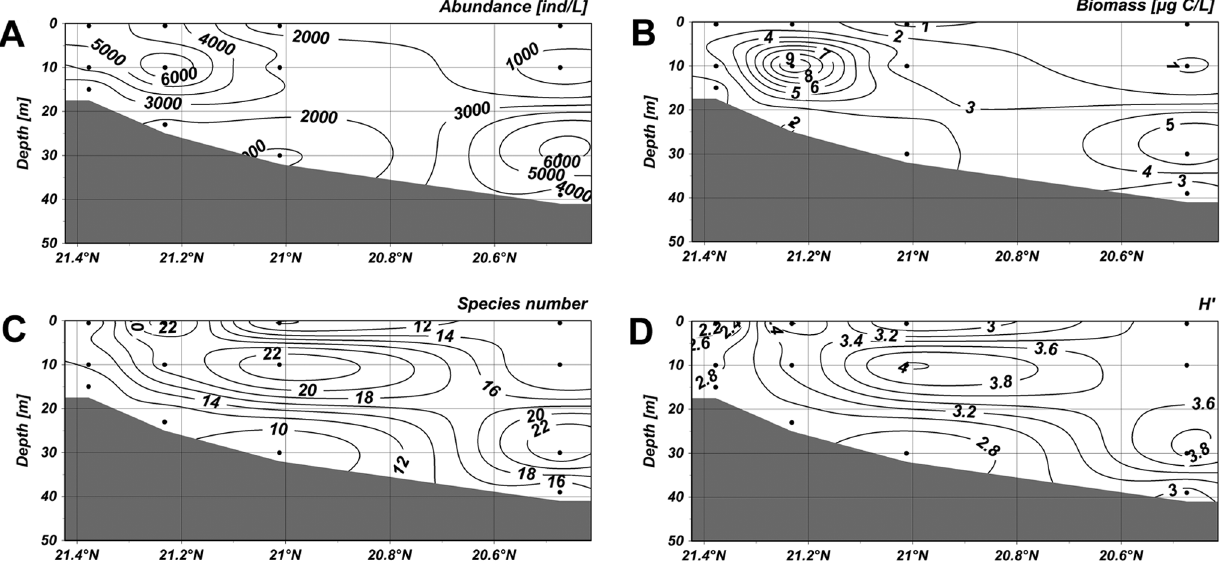
Figure 5. Vertical distribution of planktonic ciliates in the section 1–4. (A) Vertical distribution of abundance. (B) Vertical distribution of biomass. (C) Vertical distribution of species number. (D) Vertical distribution of diversity. The horizontal axis and vertical axis expressed the gradients in latitude and water depth, respectively. (TIFF).